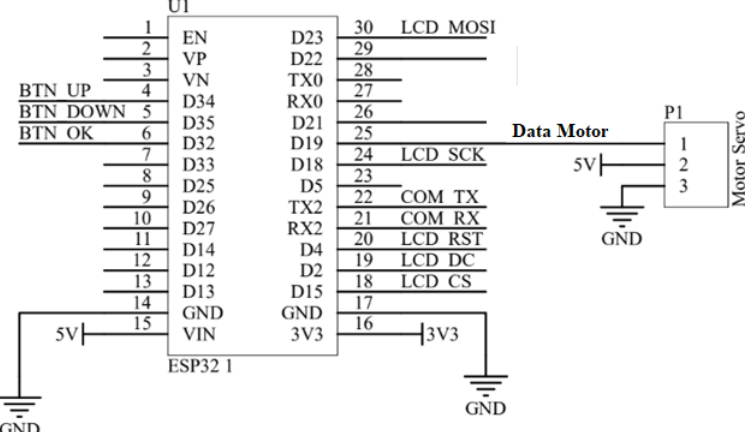
Figure 8. Schematic of servo motor.